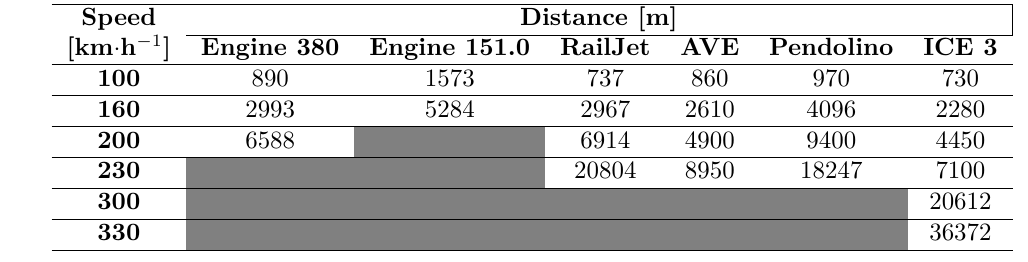
Table 2. Distance to be covered to reach the respective speed, source: Authors.